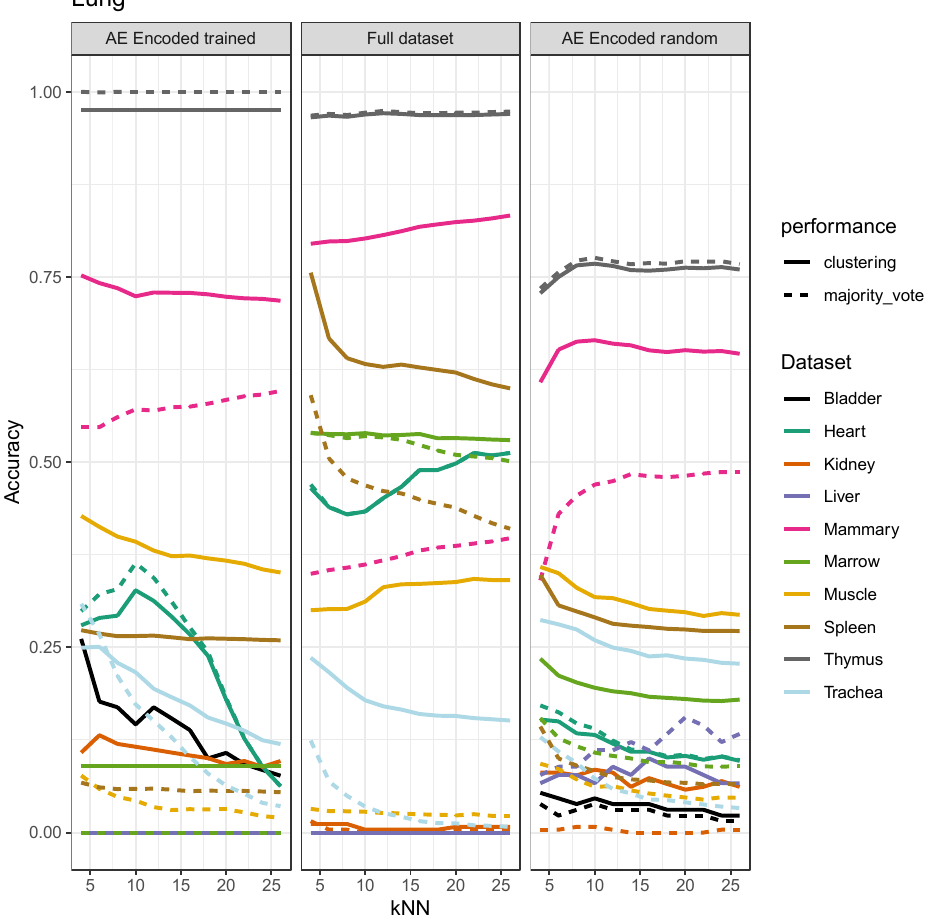
Figure 4. kNN was trained on combined Lung dataset from Smart-seq2 and 10x genomics, on data encoded by the trained autoencoder, full dataset, and dataset encoded by a randomly initialized autoencoder. Predicting cell type labels for the other combined datasets. Dashed line indicates performance when taking a majority vote as prediction, which assigns all cells to the most abundant cell type. The left represents the kNN model trained and tested on the encoded datasets, the middle represents the kNN model trained and tested on the full dataset, and the right represents the kNN trained and tested on data encoded by a randomly initialized autoencoder.